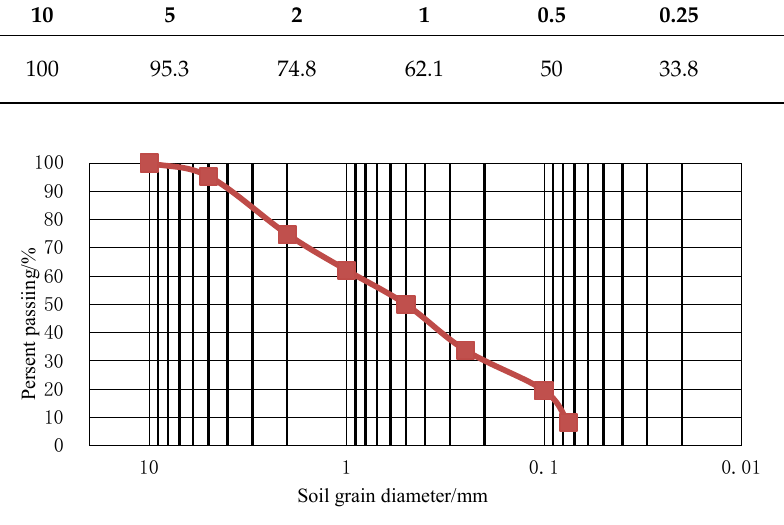
Figure 1. Cumulative particle size curve of soil samples.